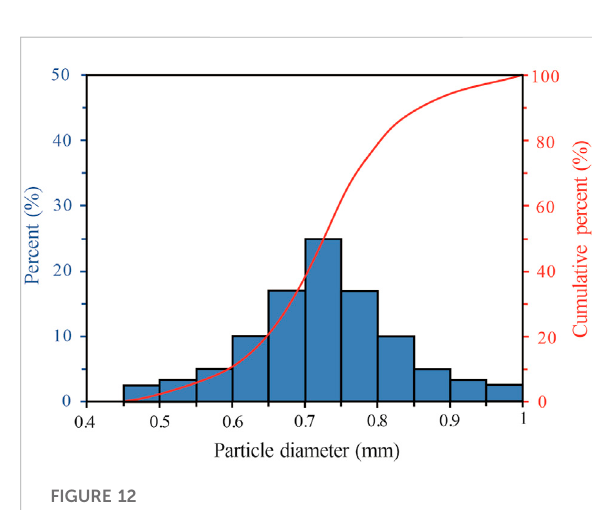
FIGURE 12 Initial particle diameter distribution of the